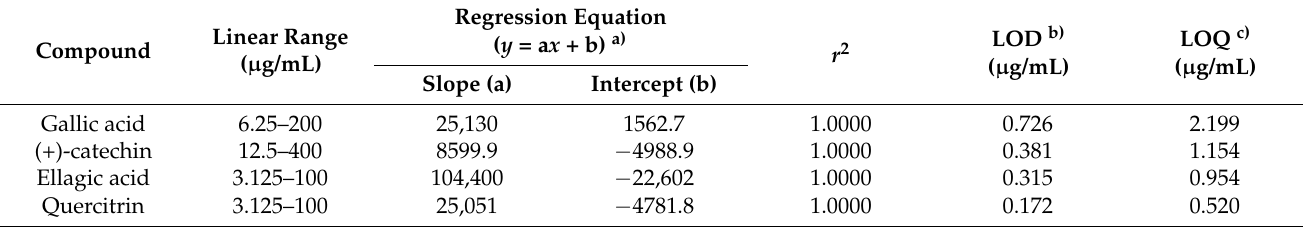
Table 1. Linear range, regression equation, correlation coefficients, limits of detection (LODs), and limits of quantification (LOQs) for compounds.